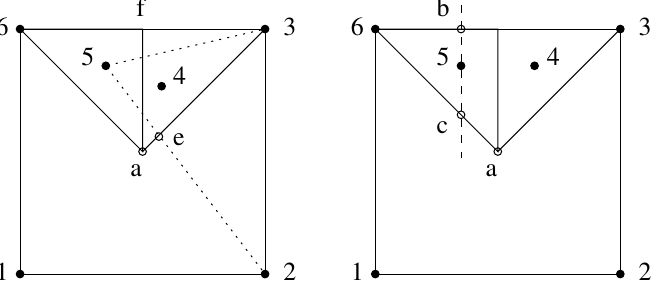
Figure 6. Optimizing the instance C 6 . At the left the positioning of the four convex hull points, 5 and the points p 5 and p 4 . At the right is shown the dashed line where is search p 5 = ( 90, y ) and p 4 = ( 255 − p 5 . x , y ) . Details in the text.